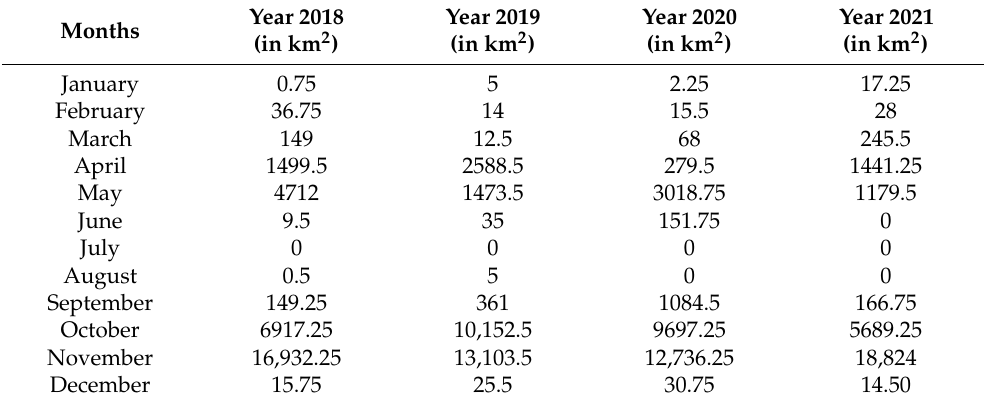
Table 2. The burned area is shown for the study site (monthly basis to define a period for pollutants estimation as stubble burning month will decide the concentration over the period in Pre-monsoon and Post Monsoon